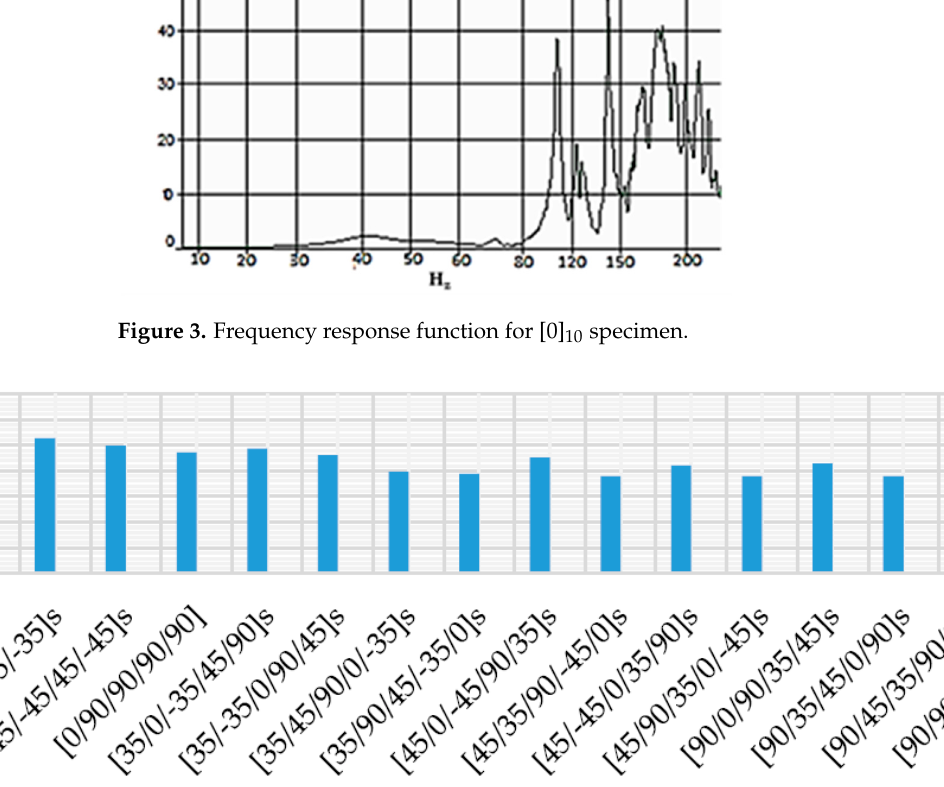
Figure 5. Variation of damping factors with stacking sequences and fiber orientations.